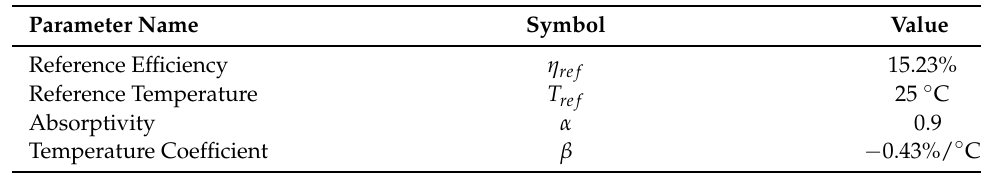
Table 2. Properties of the PV array.